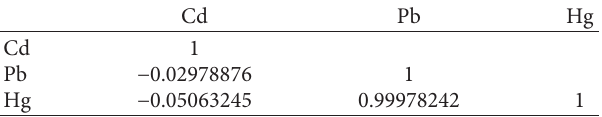
Table 6: Matrix of correlation between the different trace metals in different fish species.